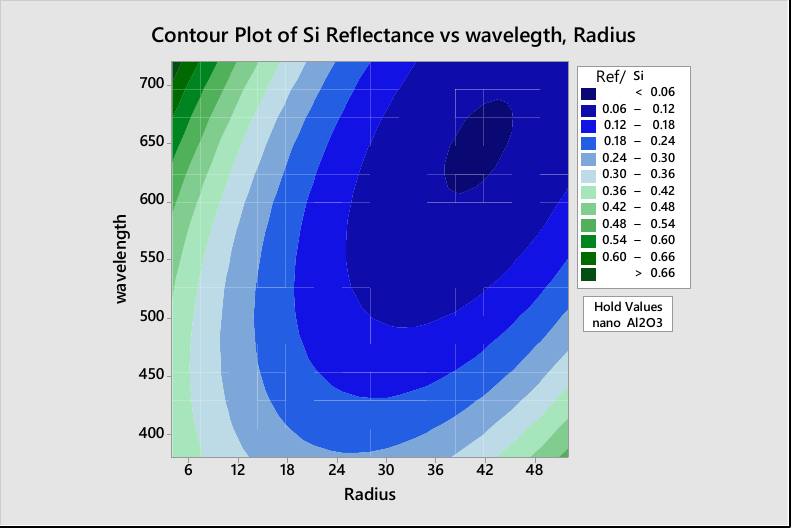
Figure 5. Contour plot of Al 2 O 3 reflectance vs. wavelength and radius.